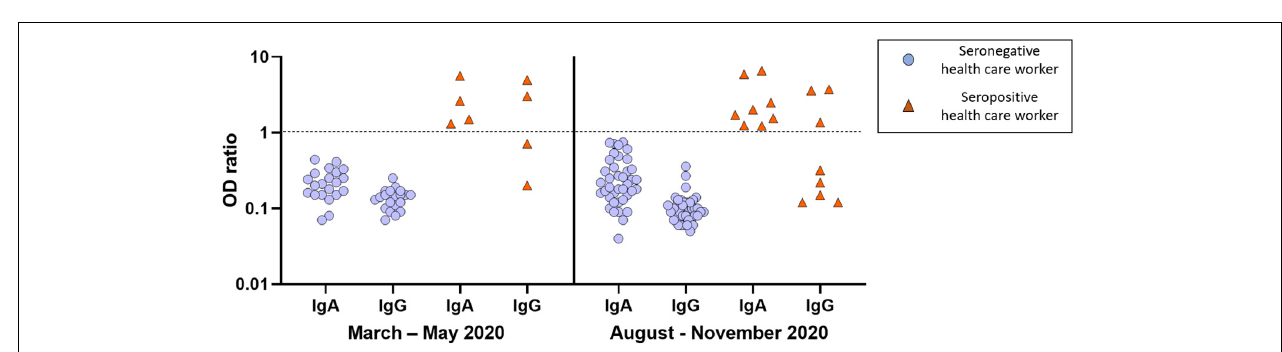
FIGURE 2 | Results of serological tests of healthcare workers in the first (March to May 2020) and second (August to November 2020) pandemic wave. Each healthcare worker was represented by a pair of IgA and IgG symbols. Red triangles represent healthcare workers with positive serological test ( n = 12: four in the first wave and eight in the second wave). Blue circles represent healthcare workers with negative serological test ( n = 61: 21 in the first wave and 40 in the second wave). A log-10 scale was used for the Y axis [log10 of OD (optical density) ratio]. The dotted line represents the threshold value of positivity. The results were interpreted as follows: negative: OD ratio < 0.8 for both IgA and IgG; indeterminate: 0.8 ≤ OD ratio < 1.1 for IgA and/or IgG; positive: OD ratio ≥ 1.1 for IgA and/or